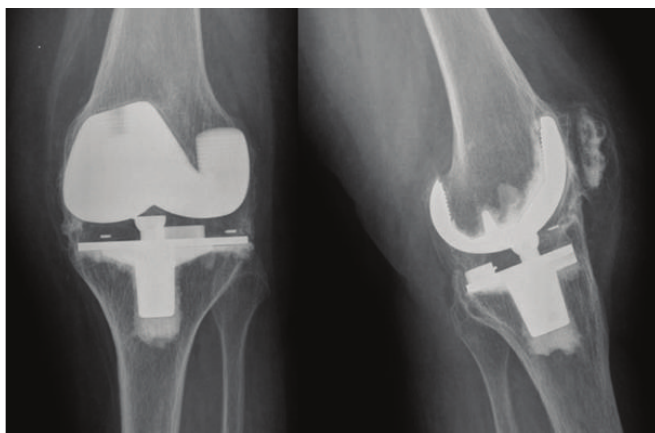
Figure 1: AP and lateral X-rays showing massive heterotopic ossification around the